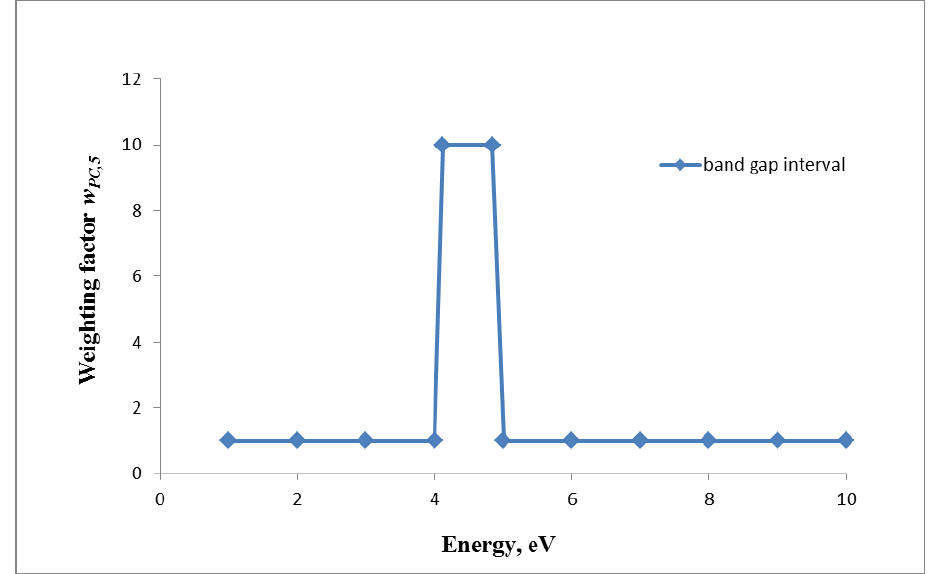
Figure 5. Weighting factor 5 ( w ) for the band gap energy levels of metal and metal PC , 5 oxides for NP larger than 20–30 nm: If NP is showing a band gap energy in the range